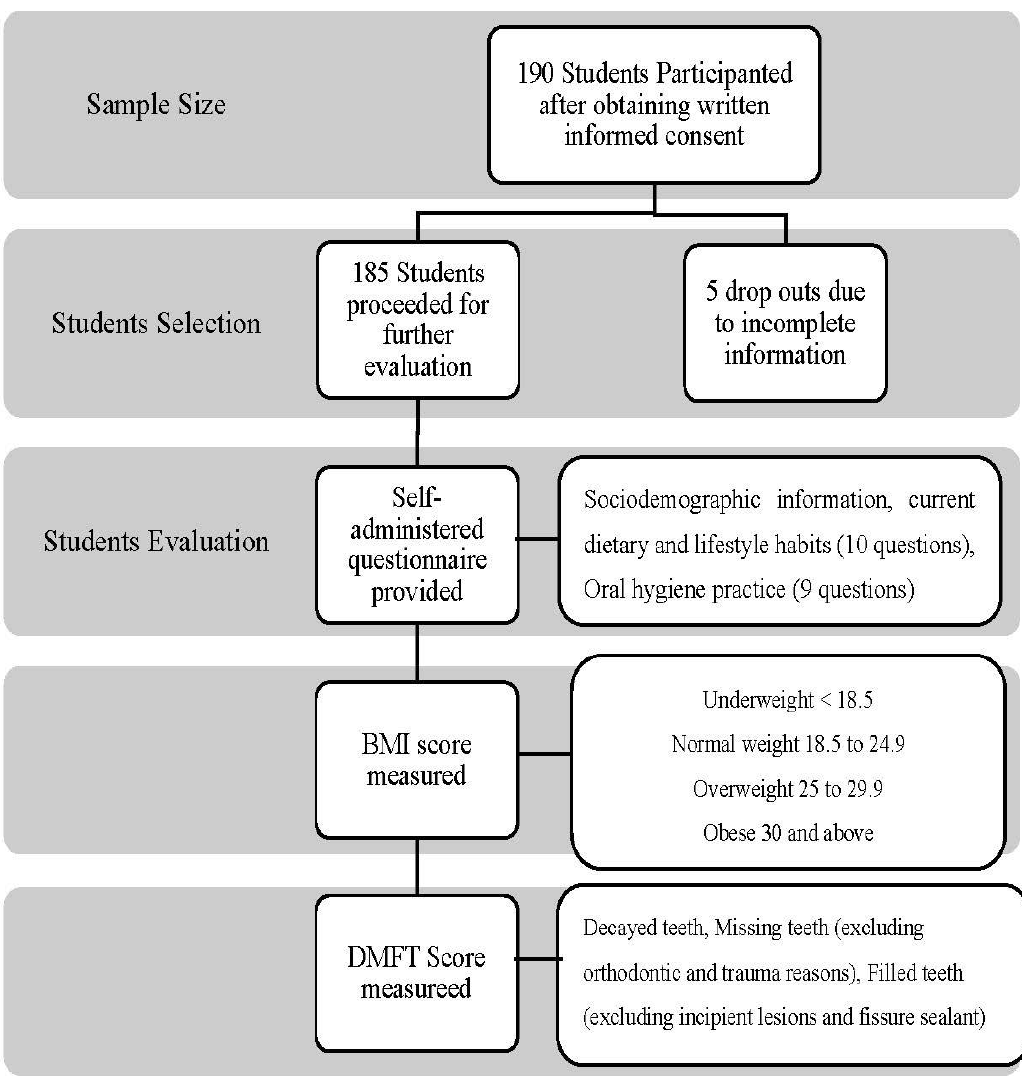
Figure 1. Flowchart of methodology.